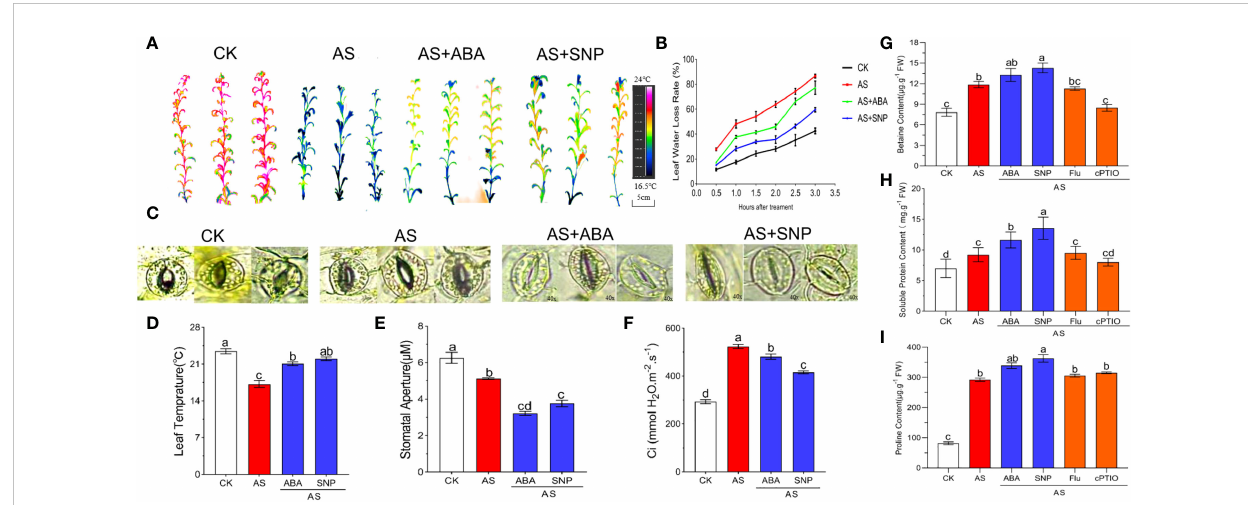
FIGURE 4 Effects of different treatments on leaf transpiration and osmomodulatory substances of N. tangutorum seedlings. 40-day-old seedlings were treated with different treatments (100 mM alkali, 100 mM alkali +15 m m ABA/5 m m Flu, 100 mM alkali +50 m m SNP/70 m m cPTIO) for 12 days(AS : NaHCO 3 : Na 2 CO 3 = 9:1, pH=9.5), and subsequent experiments are the same. Plants grew in Hoagland solution served as controls(CK). (A, B, D) : Infrared imaging, leaf water loss rate and leaf temperature of leaves of N. tangutorum seedlings under different stress treatments. (C) and (E) : stomatal phenotype and stomatal aperture of N. tangutorum seedlings under different treatments. (F) : Intercellular CO 2 concentration; (G) : Betaine content; (H) : Soluble protein content; (I) : Proline content. Bars represent the means ± SDs of three replicates. Signi fi cant differences among treatments are indicated by different letters within a panel based on Duncan ’ s multiple range test ( P <